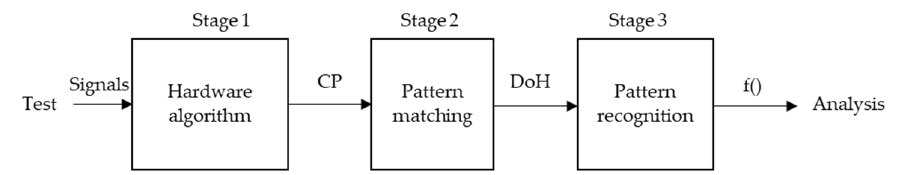
Figure 3. Flowchart of the experimental procedure proposal for detecting progressive damage in SHM monitoring.